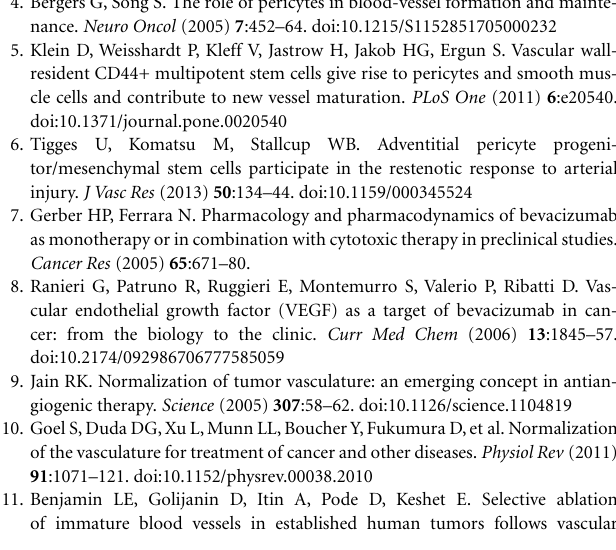
FIGURE 7 | B16F10 and LLC tumor-cell supernatants increase the mobilization and in-gel sprouting of mouse aorta cells and induce Nest-GFP MPSC differentiation into pericytes . (A) Mouse aorta fragments of Nest-GFP transgenic mice embedded in Collagen-gel were exposed to B16F10 and LLC cell culture supernatants (SN) or control supernatants, respectively. In-gel sprouting and gel invasion was followed by phase contrast